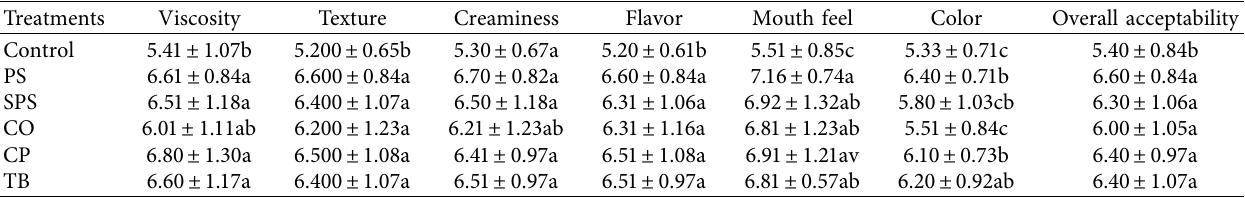
Table 4: Effect of okra gum and starches on sensory attributes of